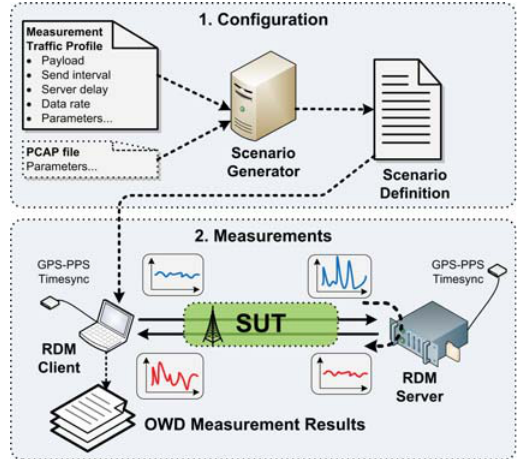
Figure 1: Overall Representative Delay Measure- ment (RDM) Architecture and Implementation tribution of measurement samples while transferring them through forward and/or reverse measurement path(s), re- spectively. The RDM server attempts to eliminate potential measurement traffic bias of the forward path before reflect- ing the packets. For this it artificially delays any packet for a small, packet-specific, client-proposed value. This is